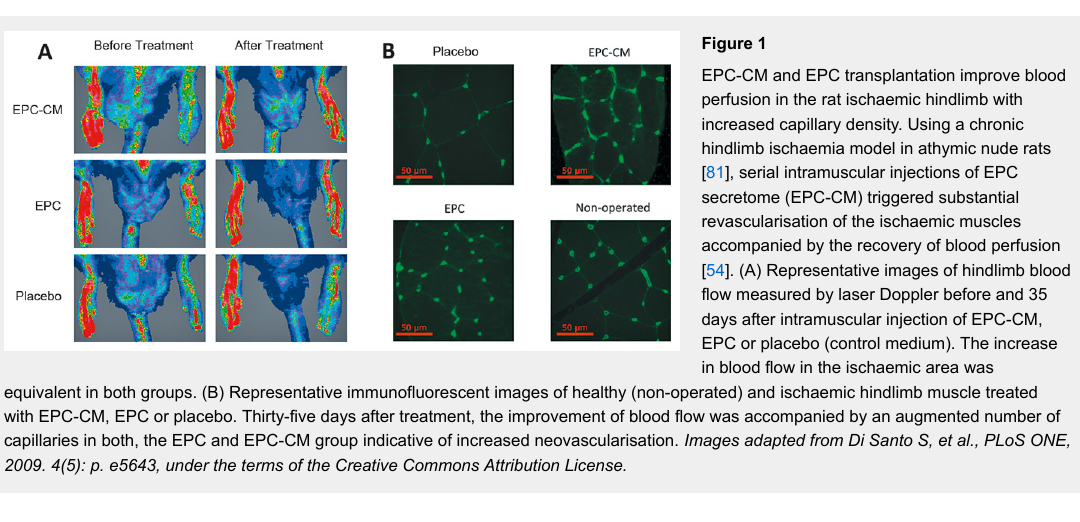
EPC-CM and EPC transplantation improve blood perfusion in the rat ischaemic hindlimb with increased capillary density. Using a chronic hindlimb ischaemia model in athymic nude rats [81], serial intramuscular injections of EPC secretome (EPC-CM) triggered substantial revascularisation of the ischaemic muscles accompanied by the recovery of blood perfusion [54]. (A) Representative images of hindlimb blood flow measured by laser Doppler before and 35 days after intramuscular injection of EPC-CM, EPC or placebo (control medium). The increase in blood flow in the ischaemic area was